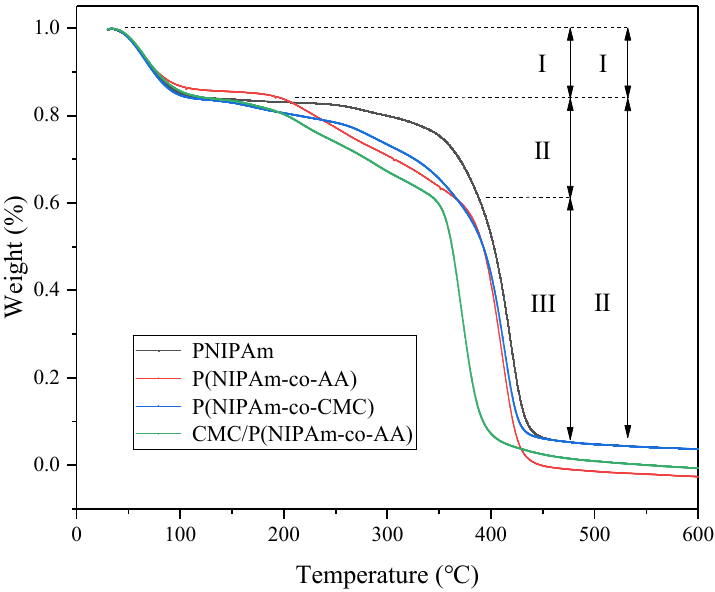
Figure 4. Thermogravimetric ( TGA) curves of P-NIPAM, P (NIPAM-co-AA), P (NIPAM-co-CMC), and CMC/P (NIPAM-co-AA) at a heating rate of 10 °C·min − 1 .